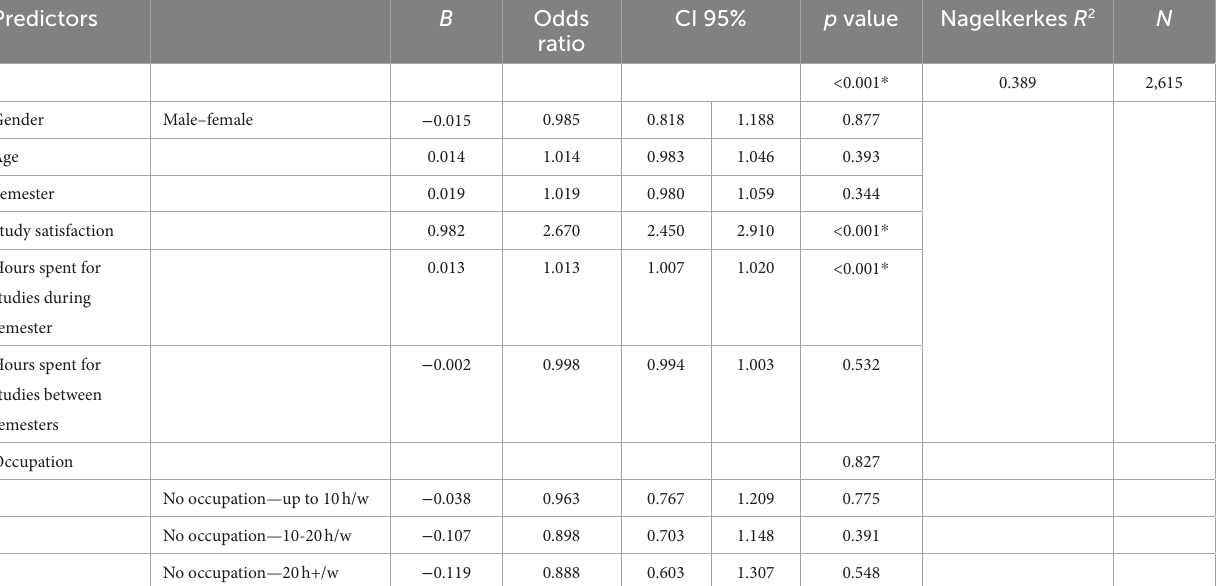
TABLE 7 Binary regression model for study